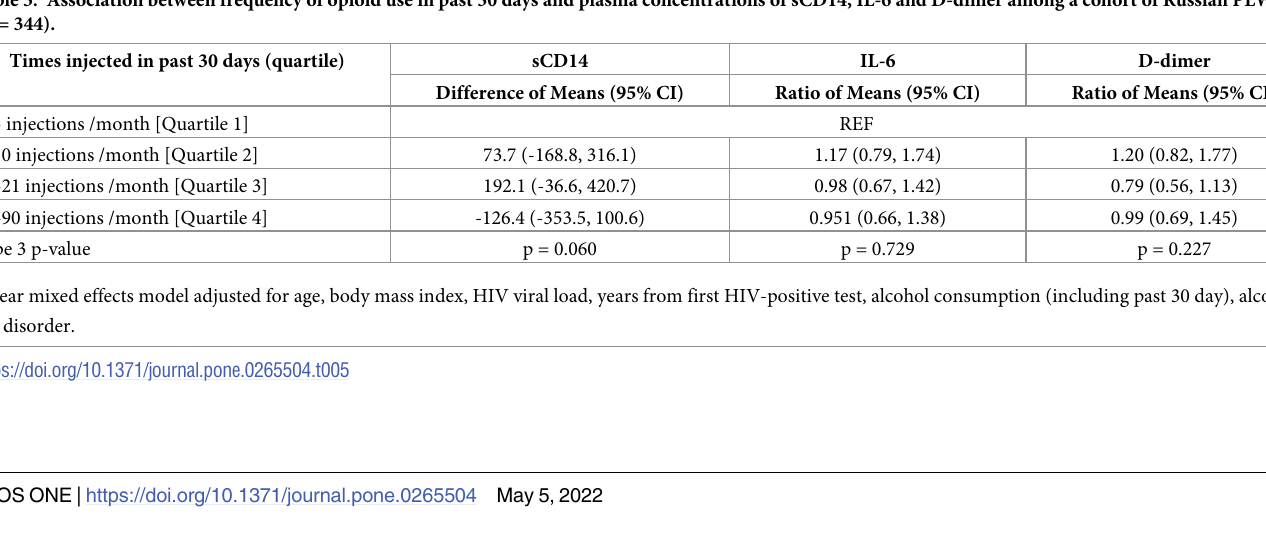
Table 5. Association between frequency of opioid use in past 30 days and plasma concentrations of sCD14, IL-6 and D-dimer among a cohort of Russian PLWH (N = 344). Times injected in past 30 days (quartile)